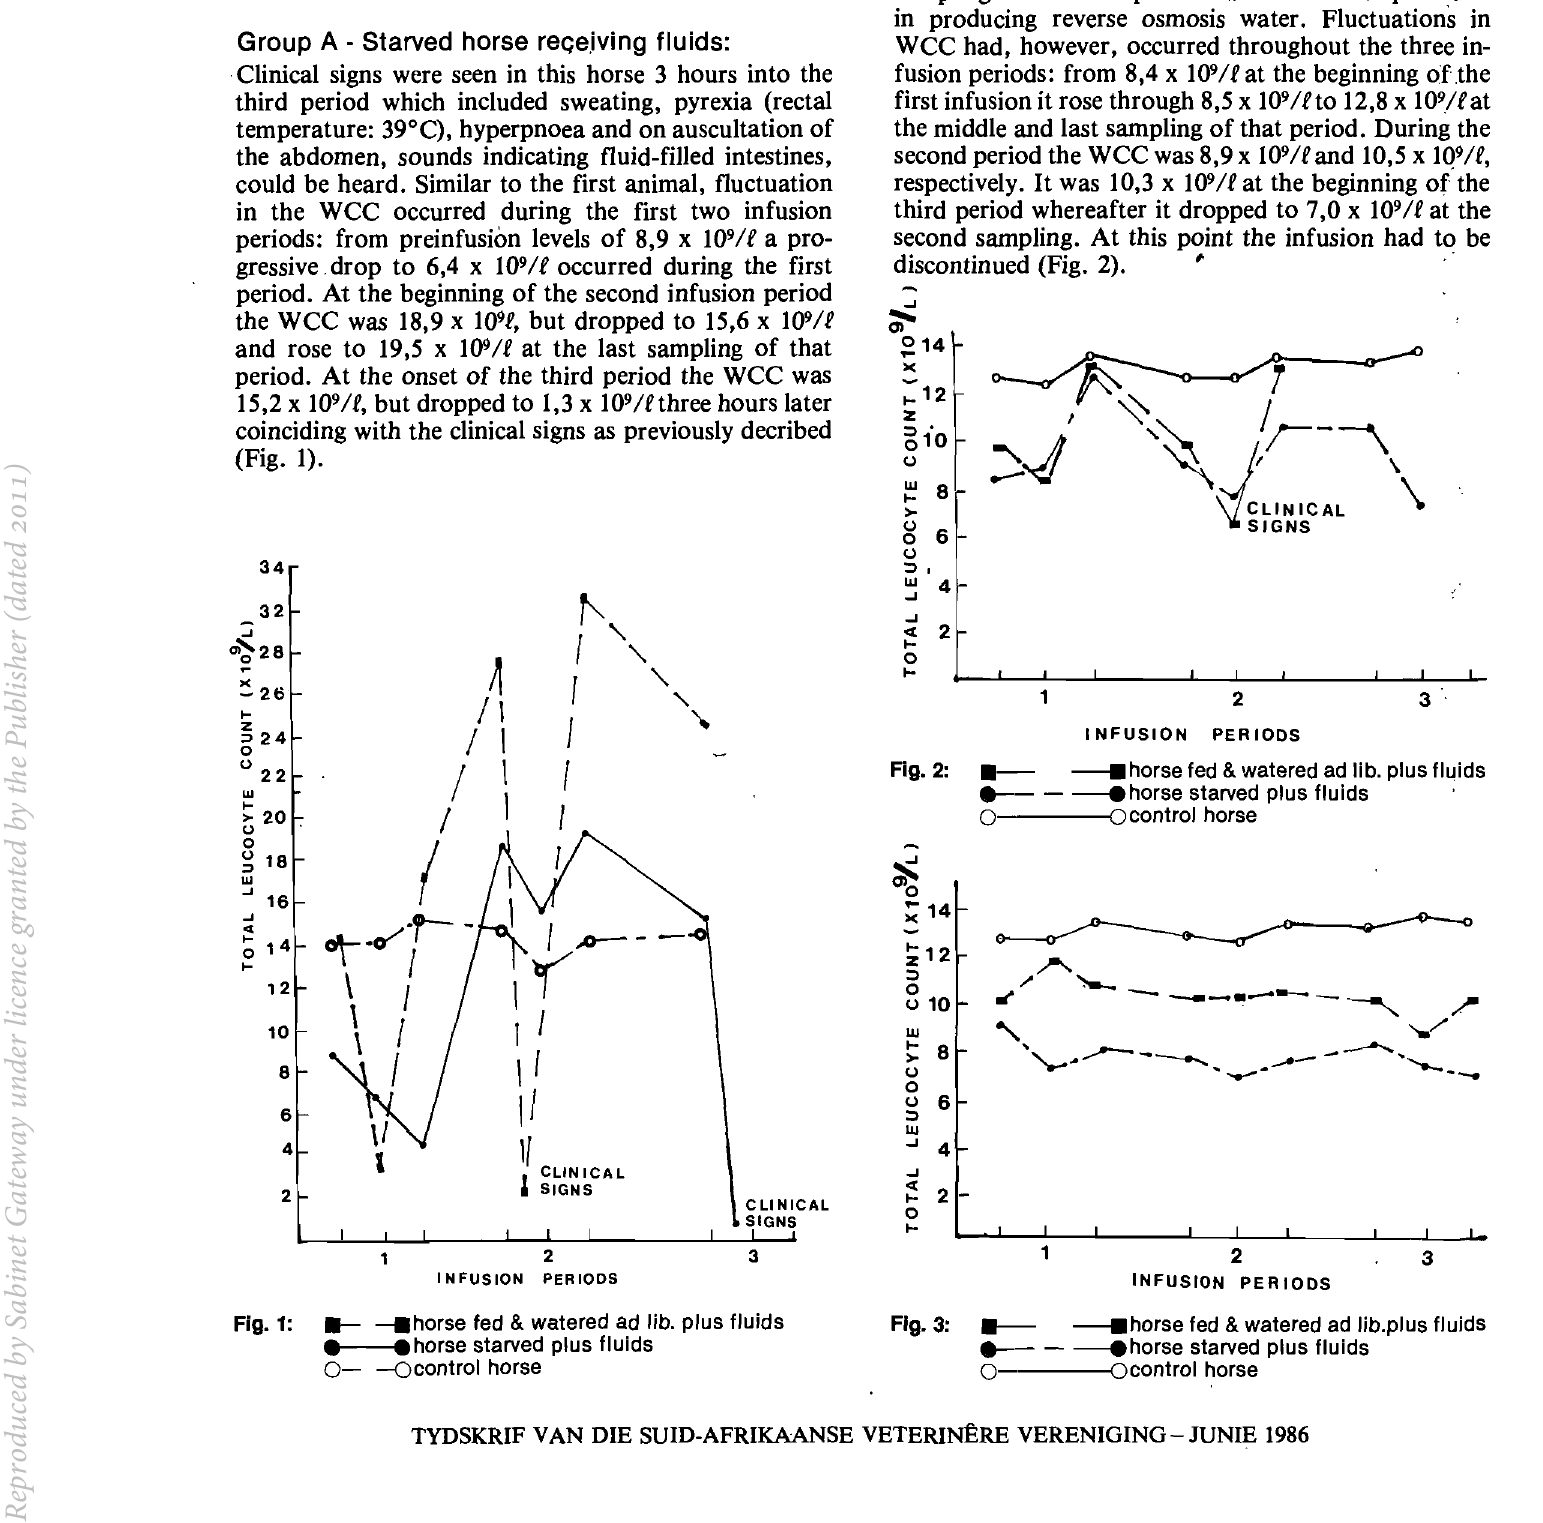
__ horse fed & watered ad lib. plus fluids • • horse starved plus fluids 0- -ocontrol